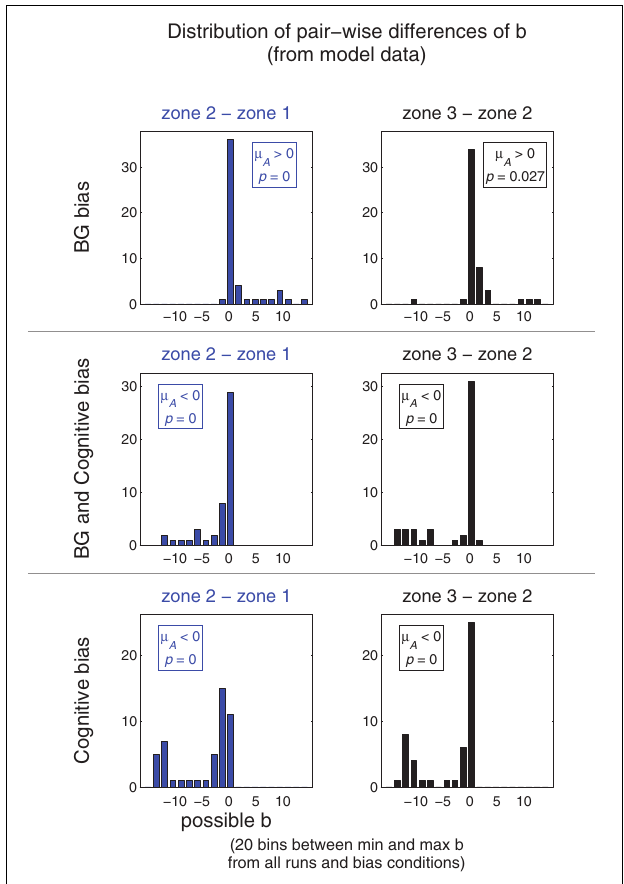
FIGURE 11 | Comparing redistribution patterns in Experiment 5: movement redistribution under different bias conditions. Each graph is a histogram illustrating the distribution of pair-wise differences (by run) of b parameters of model runs using different bias conditions (arranged by row). That for b 3 − b 2 is in the right column (black); that for b 2 − b 1 is in the left column (blue). Bin widths and locations were determined as follows: the minimum and maximum b of all possible b from all analyzed runs from all conditions defined the range of possible b . This range was divided into 20 evenly-spaced bins of uniform size. The means of the samples of b parameters were tested according to the hypotheses that they have a mean μ A > 0 or μ A < 0 (indicated, along with p value, in each